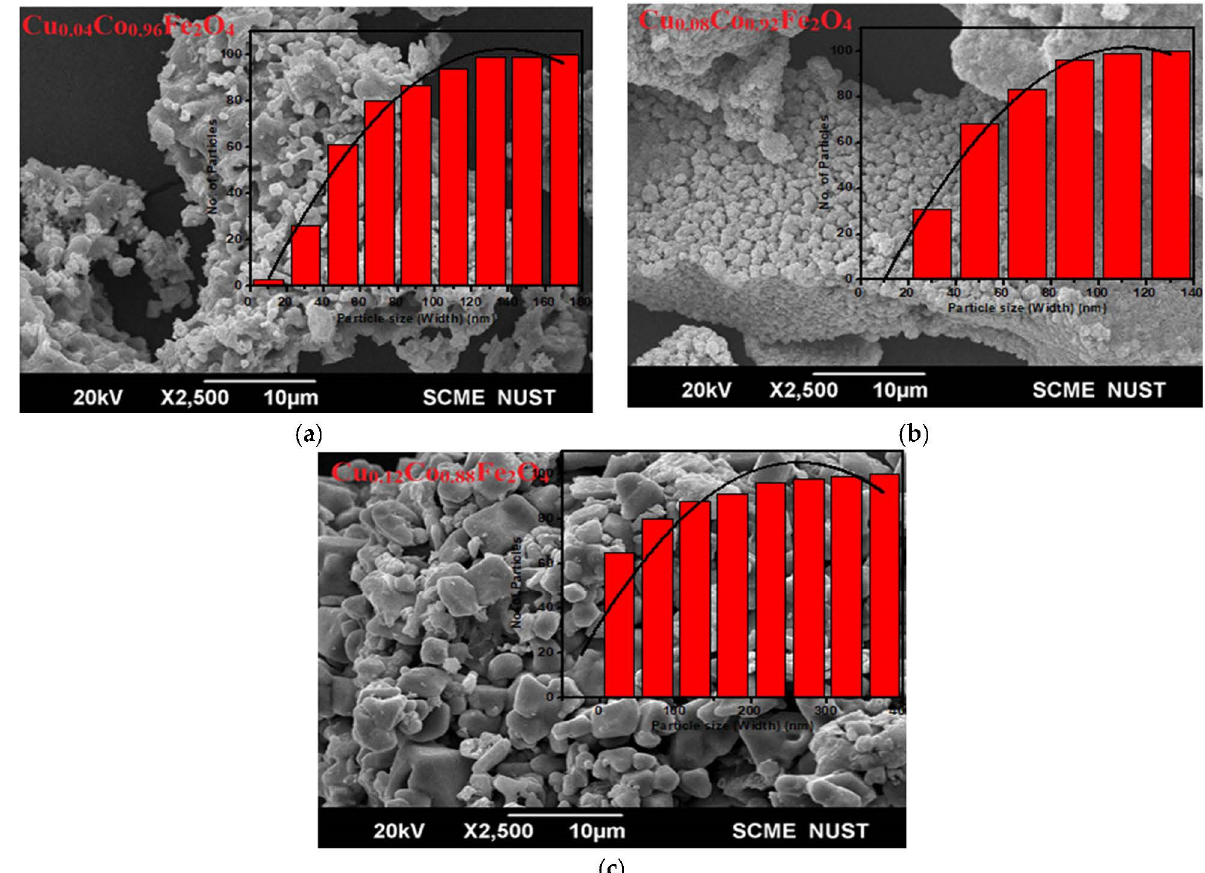
Figure 3. SEM images of ( a ) Cu 0.04 Co 0.96 Fe 2 O 4 ( b ) Cu 0.08 Co 0.0.92 Fe 2 O 4 , and ( c ) Cu 0.12 Co 0.88 Fe 2 O 4 nano- particles.